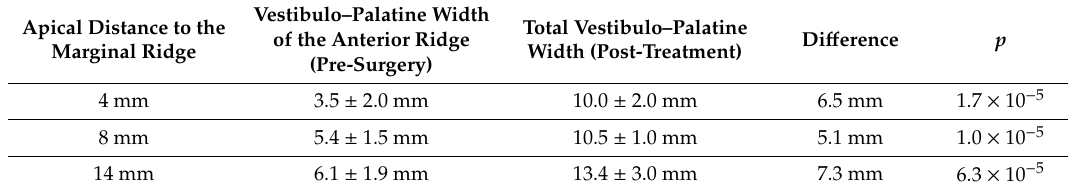
Table 4. CBTC-based bone ridge thickness